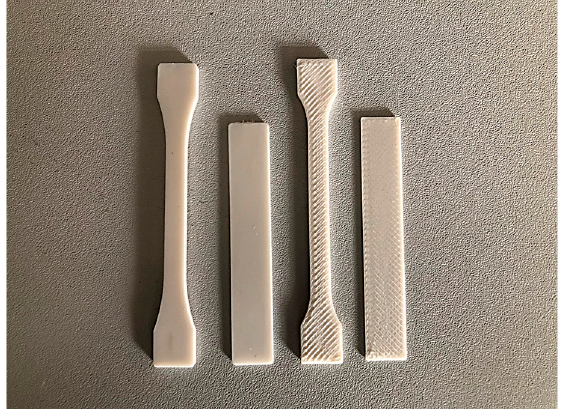
Figure 1. Samples obtained by injection molding or 3D printing.